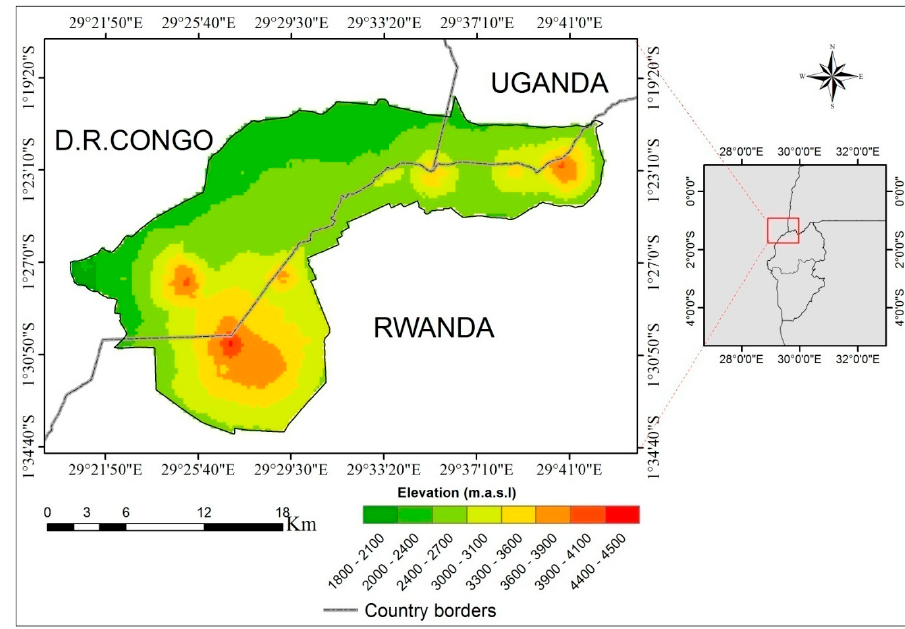
Figure 1. A map showing the location of the study area.